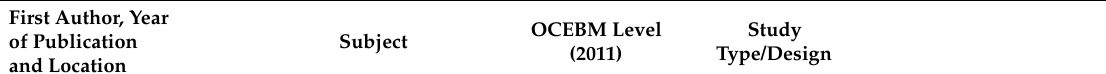
Table 1. Biological